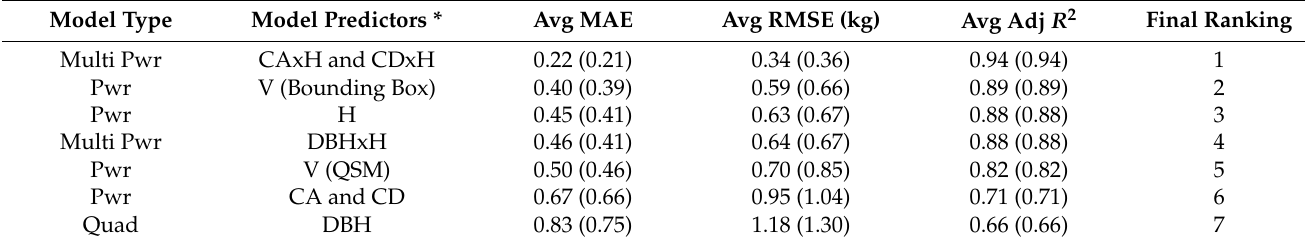
Table 3. Final rankings of the best models built for each set of predictors outlined in Section 2.9. Rankings were based on average mean absolute error (MAE), average root mean squared error (RMSE), and average adjusted R 2 obtained from the leave-one-plot-out cross validation outlined in Section 2.9 (the full rankings of all 42 models can be seen in Table S7 of the Supplementary Materials). The numbers in brackets correspond to the value of the metric when all plots (89 trees in total) are used to fit the model. Multi Pwr = multiple regression power, Pwr = power, Quad = quadratic, CA = crown area, CD = crown diameter, H = height, V (Bounding Box) = bounding box volume, DBH = diameter at breast height, V (QSM) = QSM-derived volume, QSM = quantitative structure model.